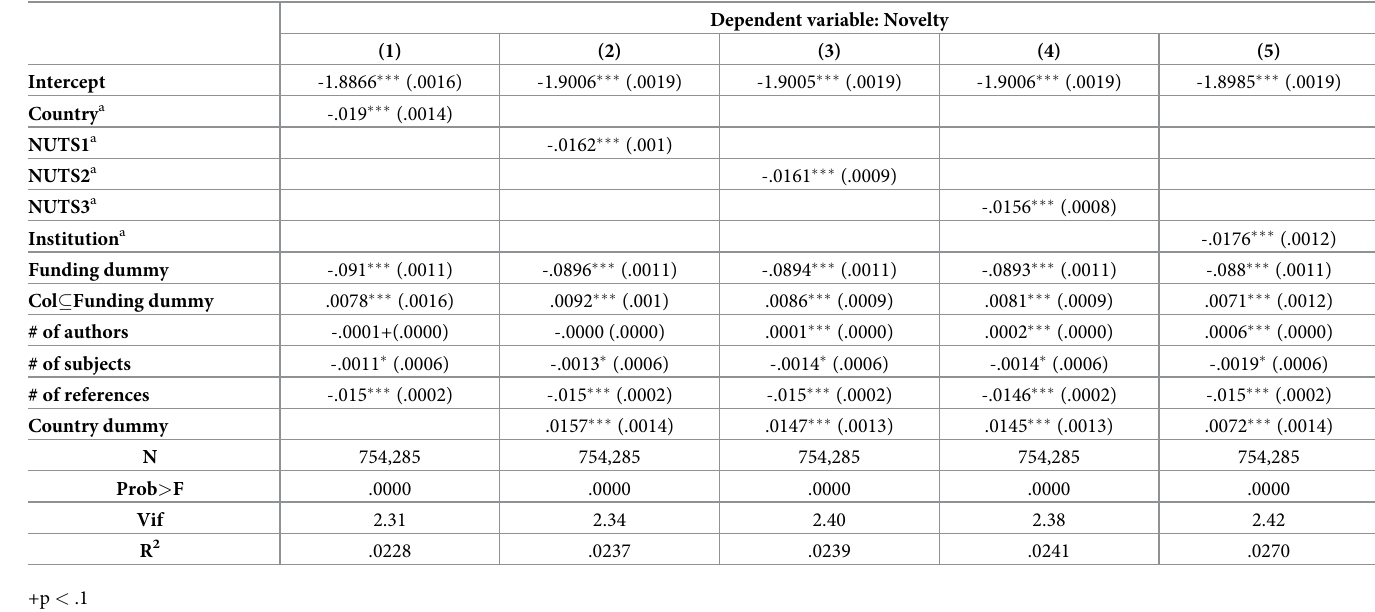
Table 2. Regression results